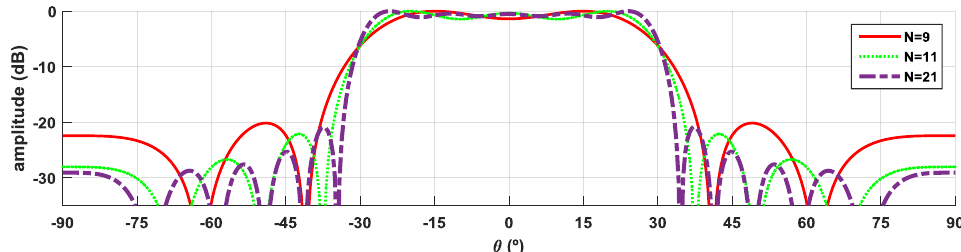
Figure 6. Variation of theoretical array response with the number of elements of the array, using Fourier transform method (FTM) coefficients.